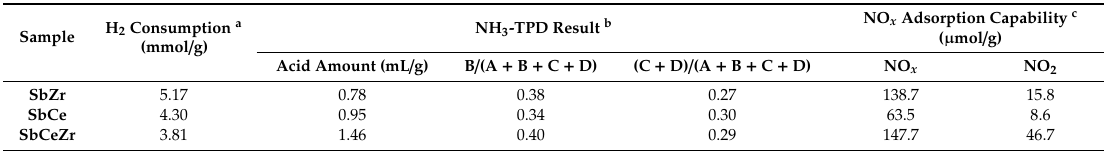
Figure 5. H 2 -TPR profiles of the catalysts.